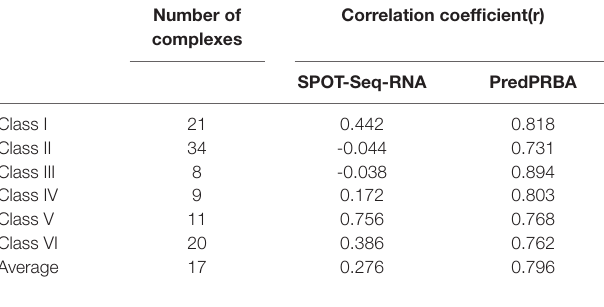
TABLE 7 | Comparison of correlation coefficients between SPOT-Seq-RNA method and Pred